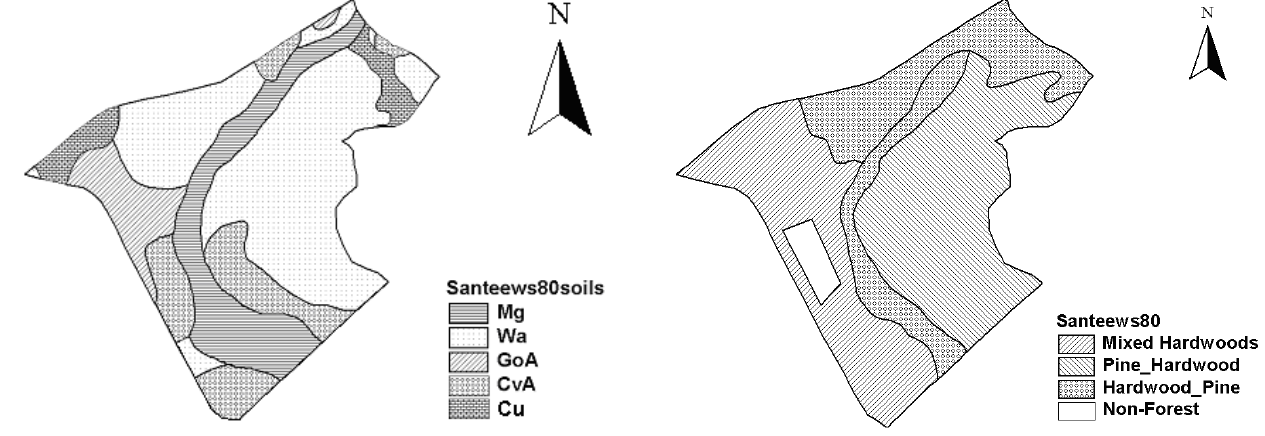
Fig. 2a. Distribution of soil types in WS80. Mg is Meggett, loam; Wa is Wahee, loam; GoA is Goldsboro, sandy loam; CvA is Craven, loam; Cu is Coxville, fine sandy loam.